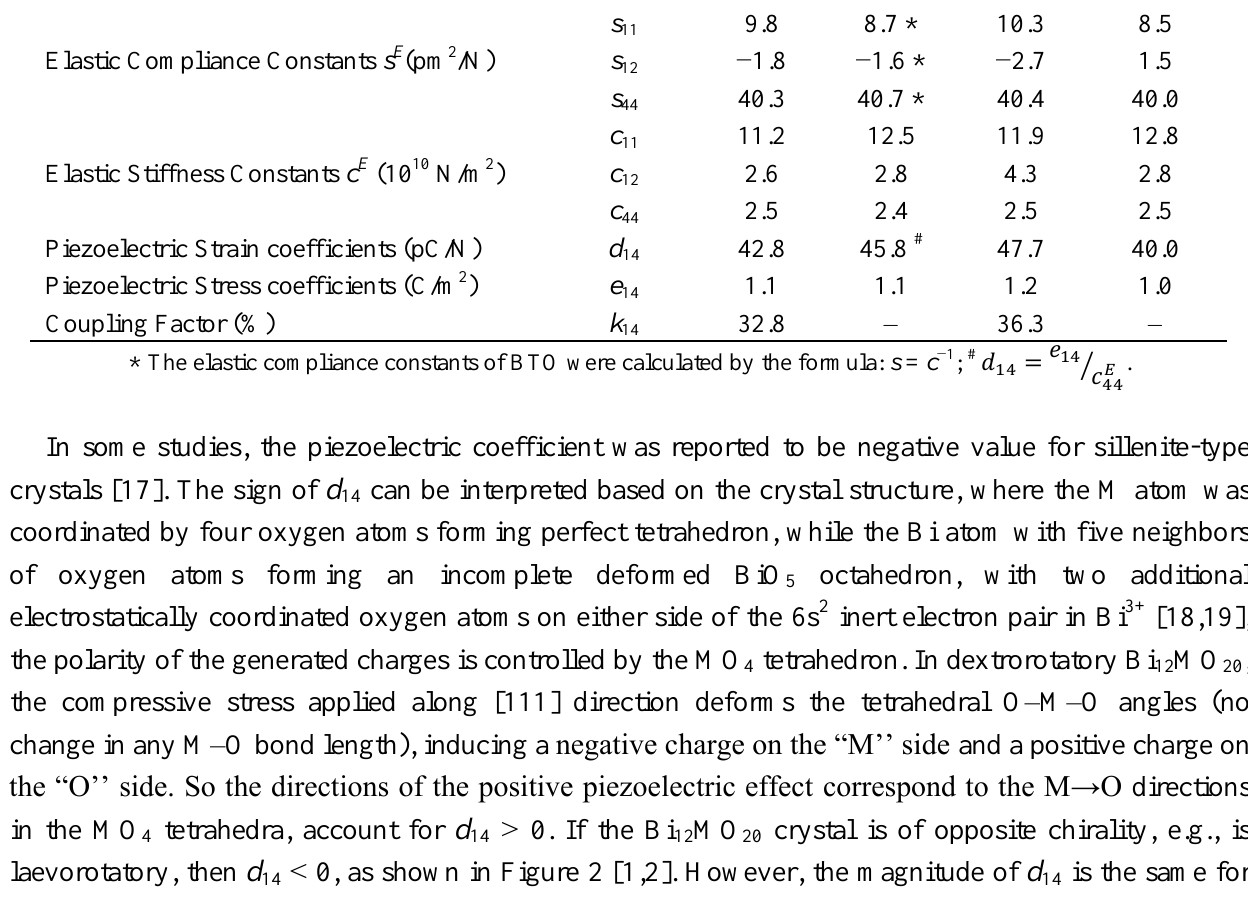
Table 1. Room temperature electro-elastic constants for BTO and BSO crystals. Electro-Elastic Constants Symbols BTO BTO [8] BSO [13] Relative Dielectric